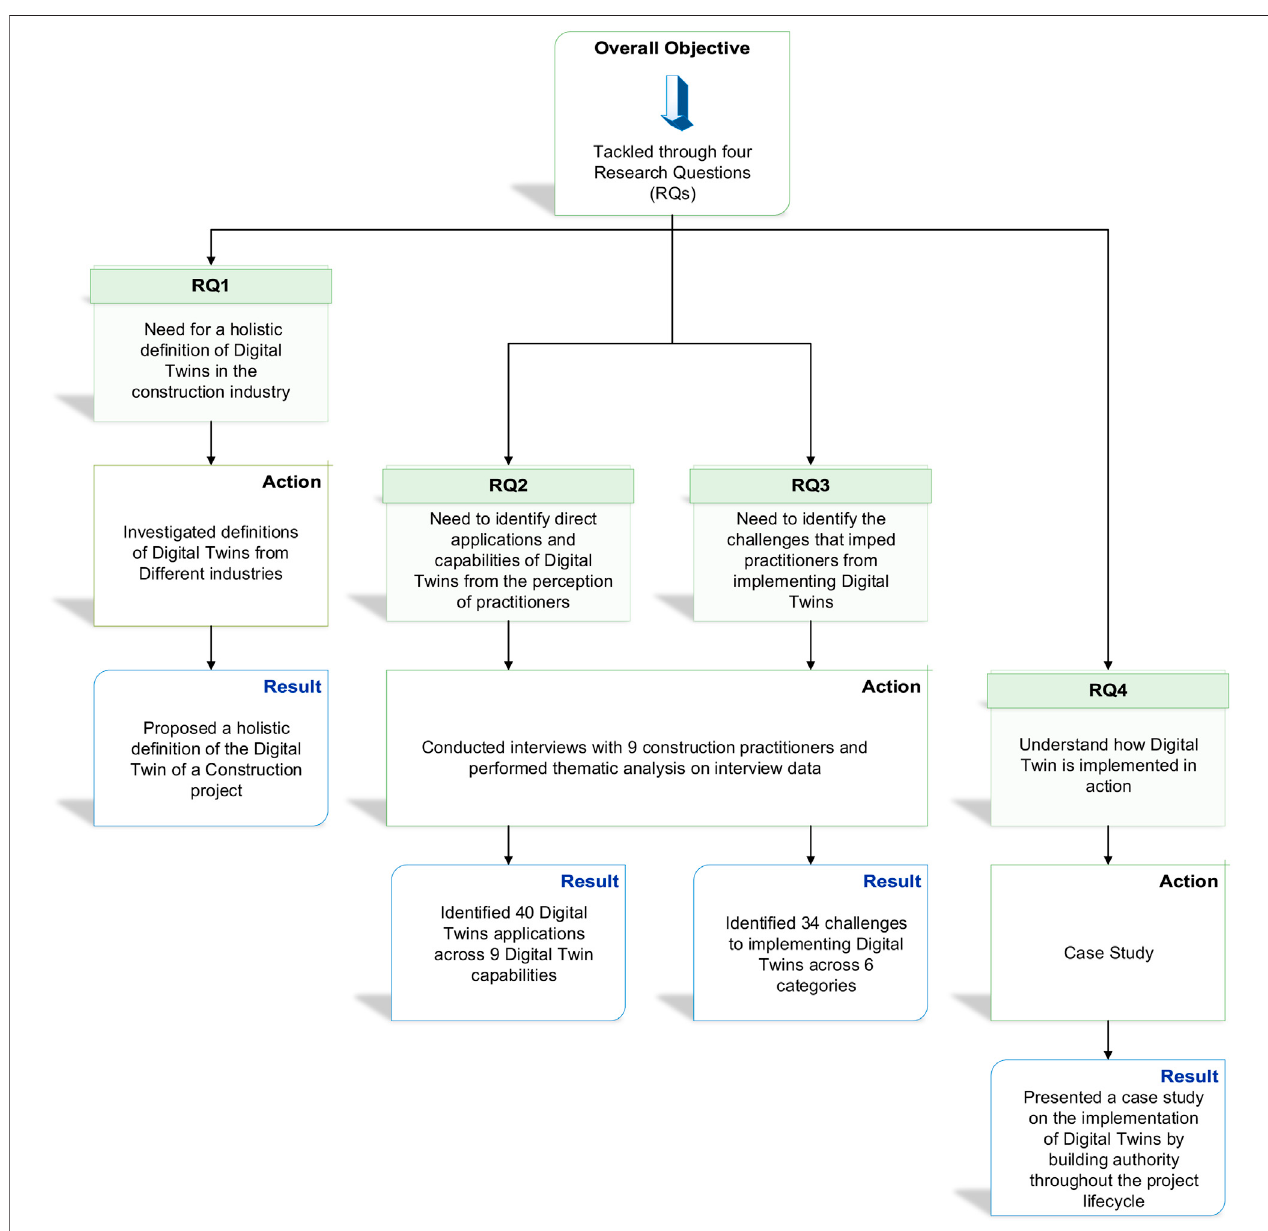
FIGURE 1 | Overview of the